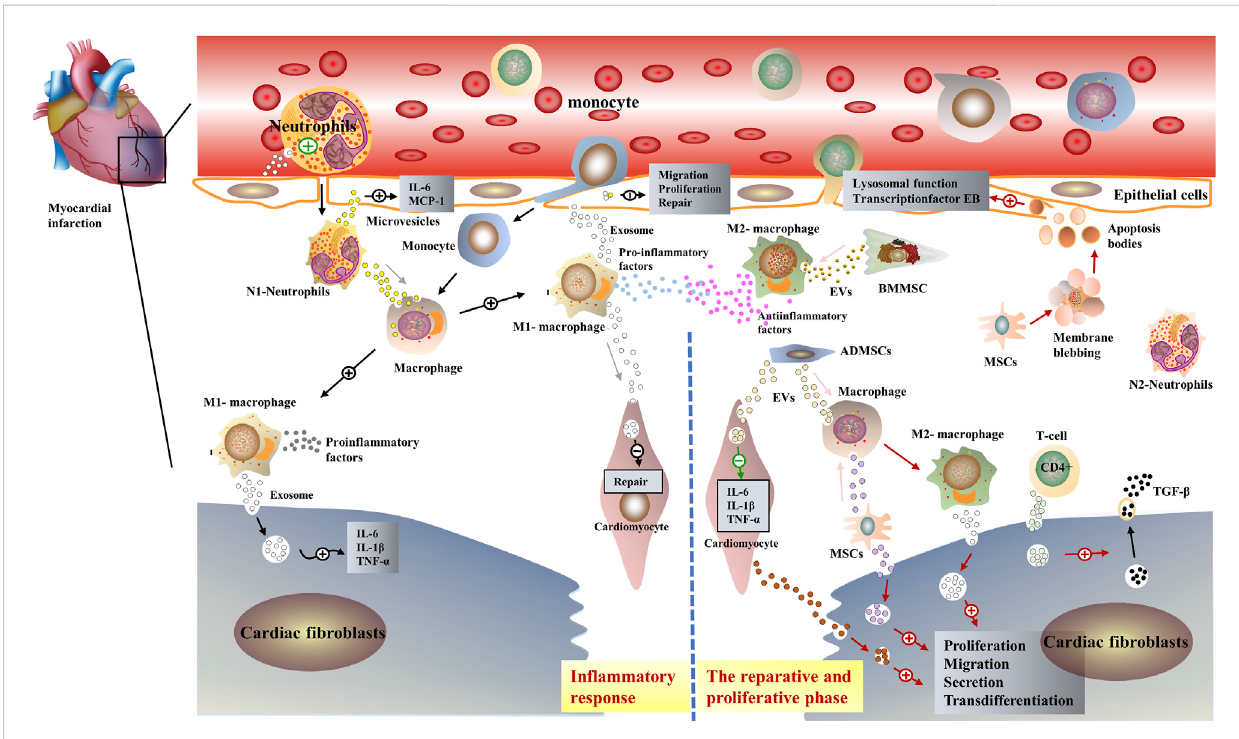
FIGURE 2 Schematicrepresentationoftheroleofextracellularvesiclesinpost-infarctioncardiacremodeling.EVshavesimilarbiologicalpropertiestoparental cells,intheearlyin fl ammatoryphasepost-infarction,immunecellssuchas pro-in fl ammatoryM1-MØandneutrophils,secretexosomescontainingpro- in fl ammatory miRNAs. Interaction with myocardial fi broblasts and endothelial cells exacerbates the in fl ammatory response in the infarcted area (Xiong et al., 2021). Subsequently, anti-in fl ammatory M2-MØ and immune cell-derived exosomes such as neutrophils dominate, interacting with mesenchymal stem cells as well as cardiomyocytes to exert anti-in fl ammatory effects (Wu et al.,